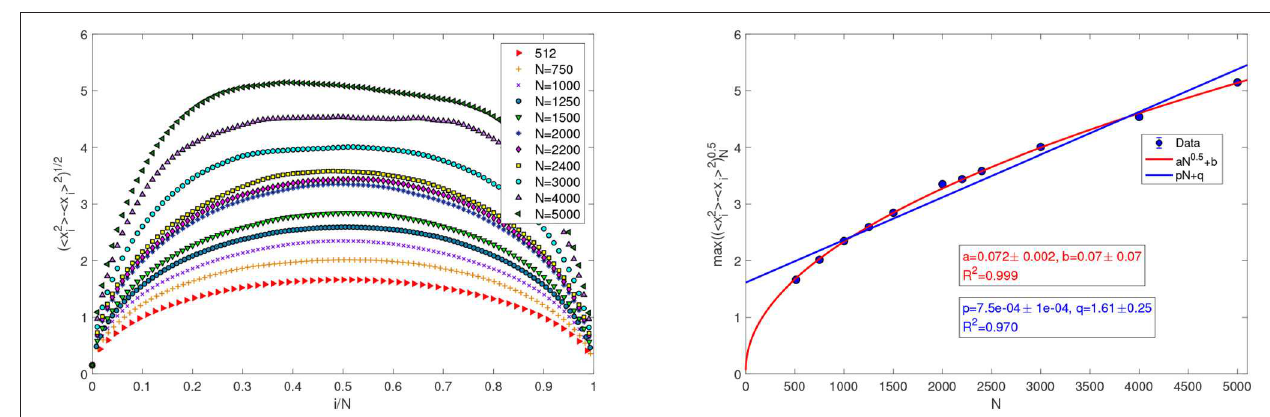
T R FIGURE 5 | Equilibrium simulations ( T L 5) for N ranging from 512 to 5000. (Left) Standard deviations of the particles vibrations about their average position = = x i ( x i ), in lattice vectors units. (Right) Dependence on N of the maximum standard deviation, together with linear and square root fits. This dependence on N − h i should not be confused with the O ( √ i ) dependence on i of Peierls [38].